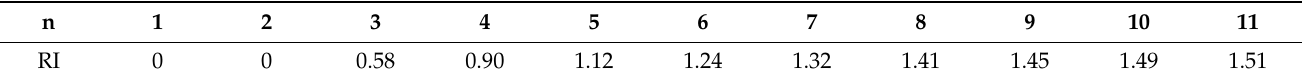
Figure 5. Maps showing causative factors in this study area with GIS.